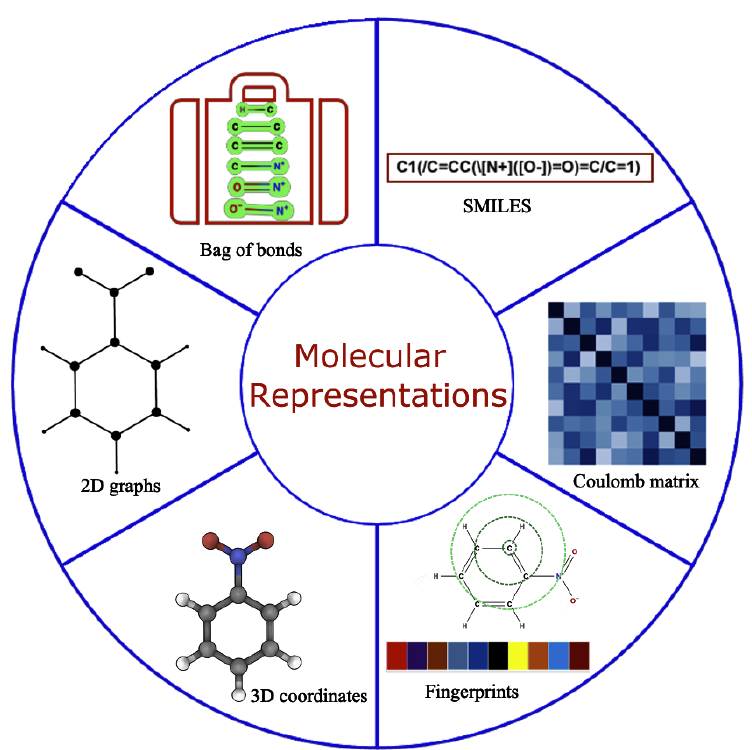
Figure 2. Molecular representation with all possible formulation used in the literature for predictive and generative